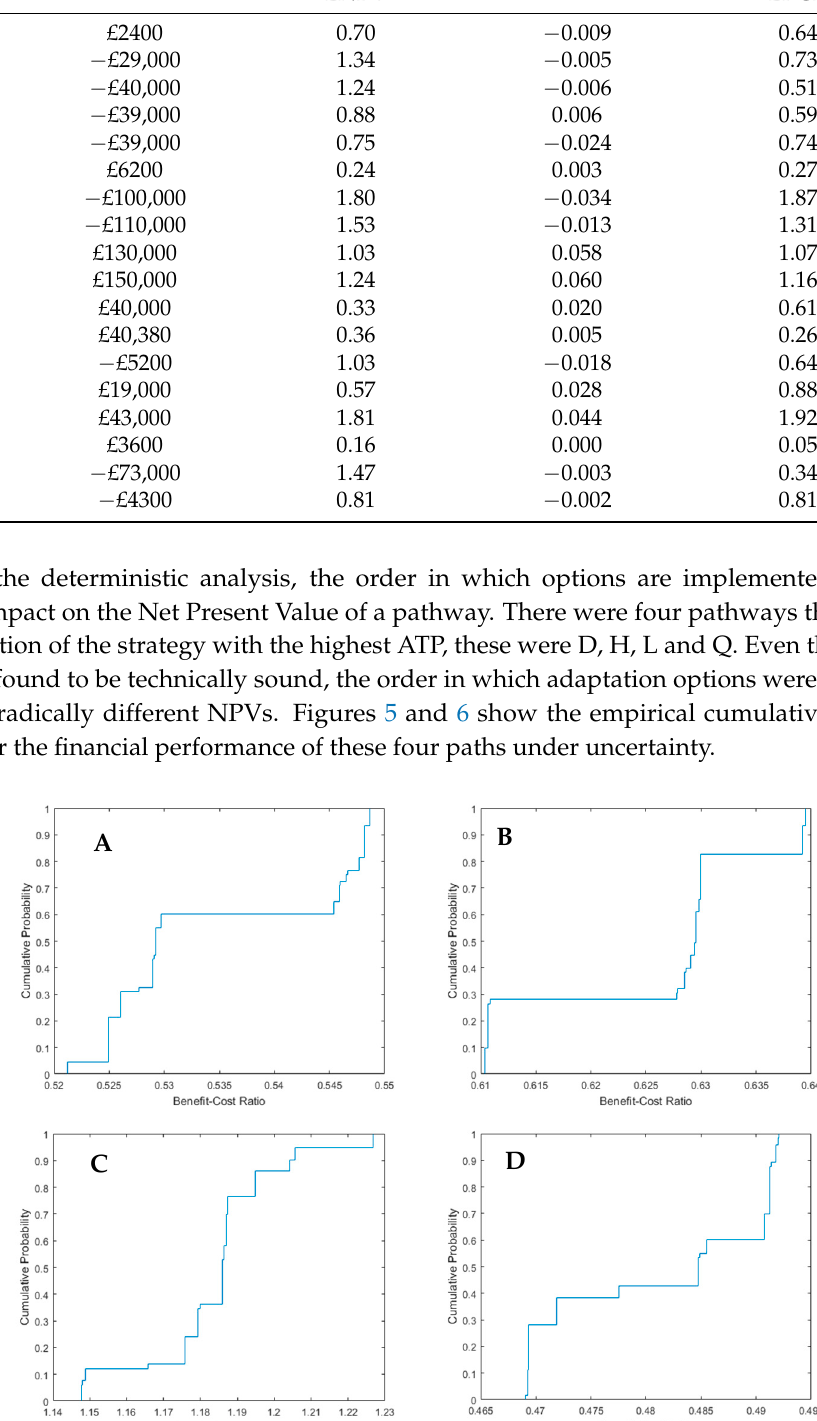
Figure 6. Empirical Cumulative Distribution Function of the Net Present Values for paths D (subfigure ( A )), H (subfigure ( B )), L (subfigure ( C )), and Q (subfigure ( D )). All four of these paths resulted in financial performances that were clearly positive or negative. This would suggest that the effects of uncertainty could not counteract the effect of path dependence, indicating that, for this case study, the order in which adaptations are implemented is paramount, and the effect of precipitation uncertainty is a secondary consideration. Two hundred simulations of the future were generated and used to assess the financial performance of the pathways. These simulations were developed by sampling from a probability density function estimated by the UK Environment Agency [13] using a Monte Carlo method. While